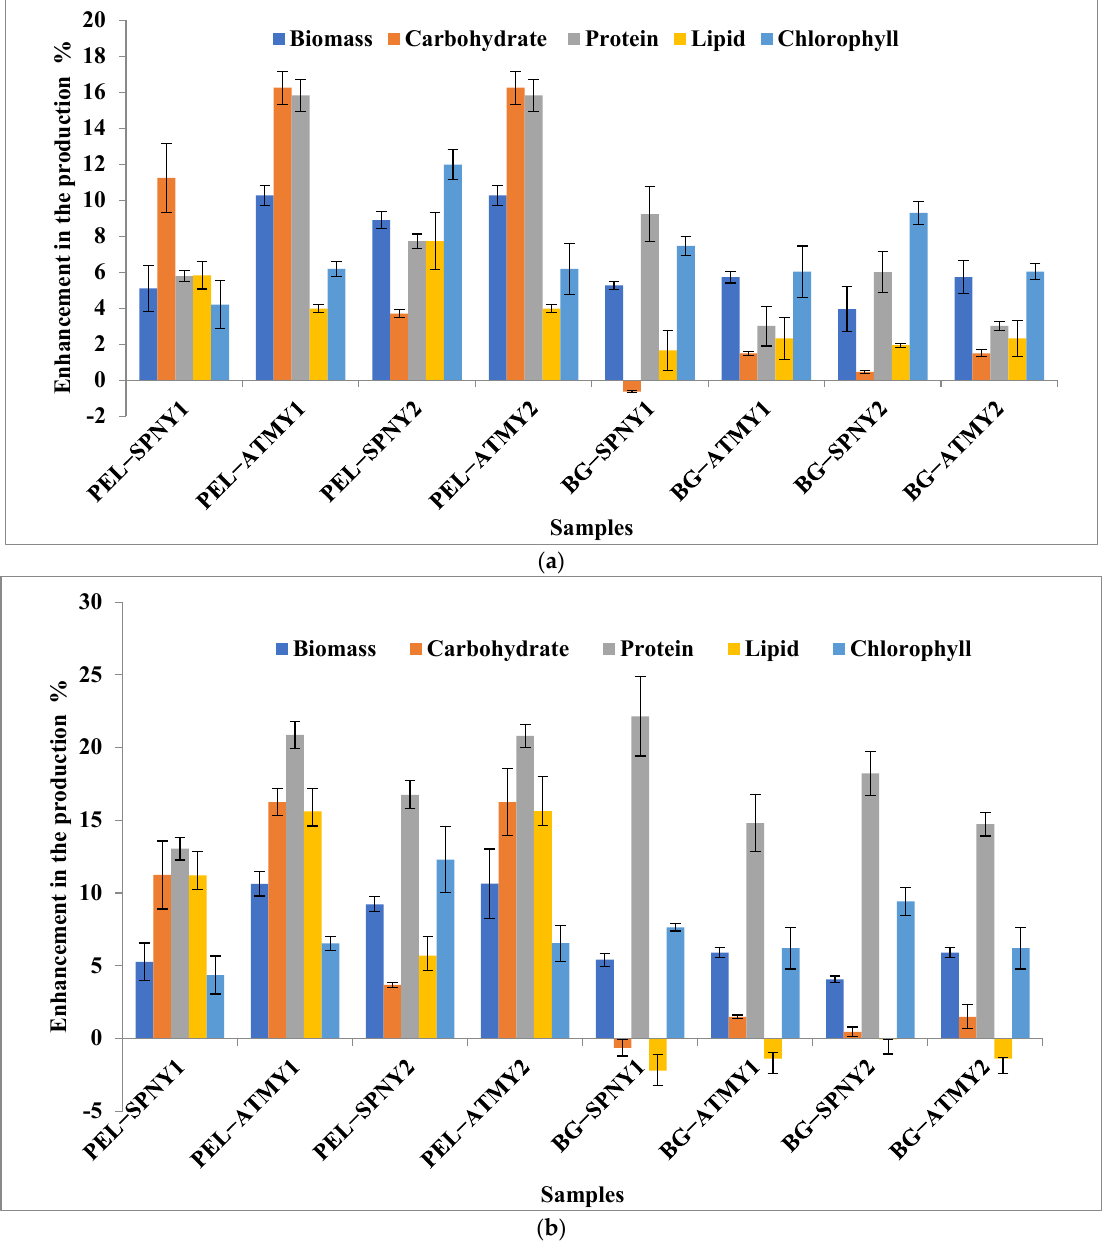
Figure 8. Enhancement in the production of biomass and biomolecules at 47.9° with respect to 32.9°: ( a ) yield; ( b ) productivity.